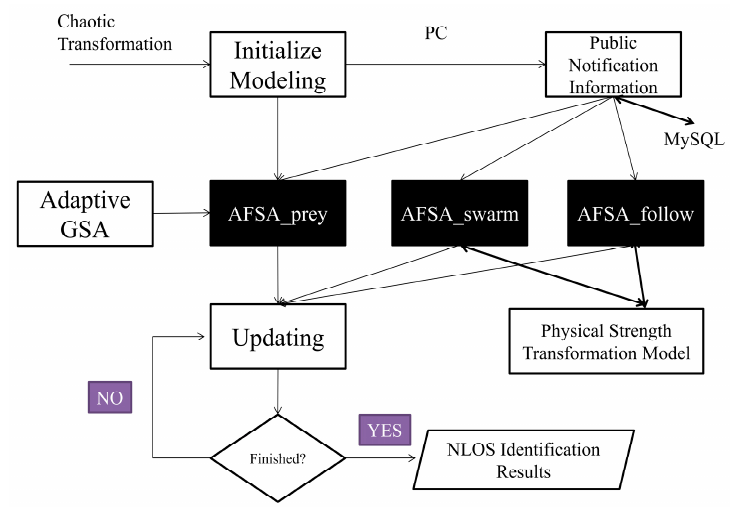
Figure 5. CTGSA main optimization method.